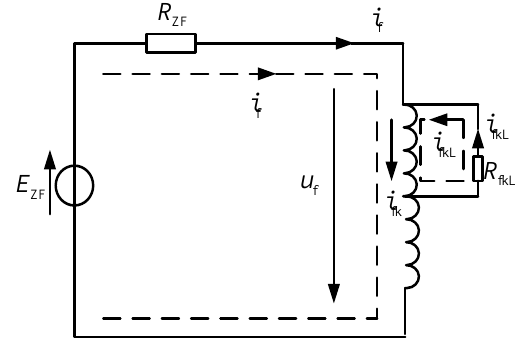
Figure 2. Loops of field windings with inter-turn short circuit.